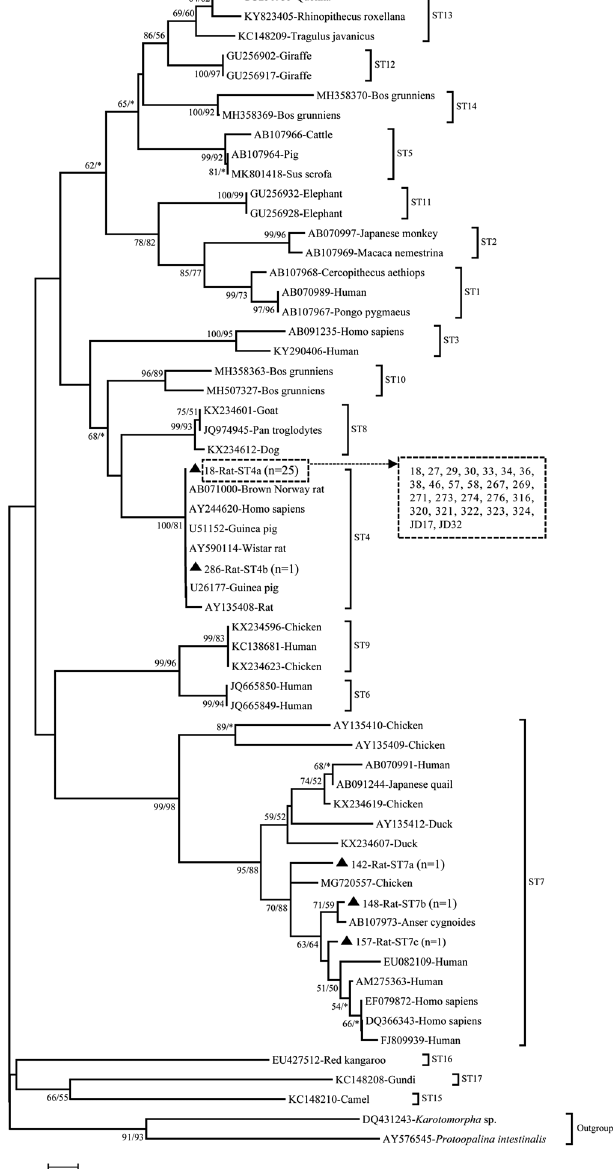
Figure 1. Phylogenetic relationships of the Blastocystis sp. subtypes identi fi ed in the present study and other reference subtypes. The phylogeny was inferred with both neighbor-joining (NJ) and maximum likelihood (ML) analysis. Evolutionary distances were computed using the maximum composite likelihood method with rate variation among sites modeled using a gamma distribution (shape parameter = 0.5). The percentage of trees that clustered together based on a bootstrap test (1000 replicates) and posterior probabilities (expressed as a percentage) are shown beside the branch nodes. An asterisk indicates a value of less than 50%; if both analyses produced values lower than 50%, no values are shown for that node. The genotypes detected in present study in bold are shown with fi lled